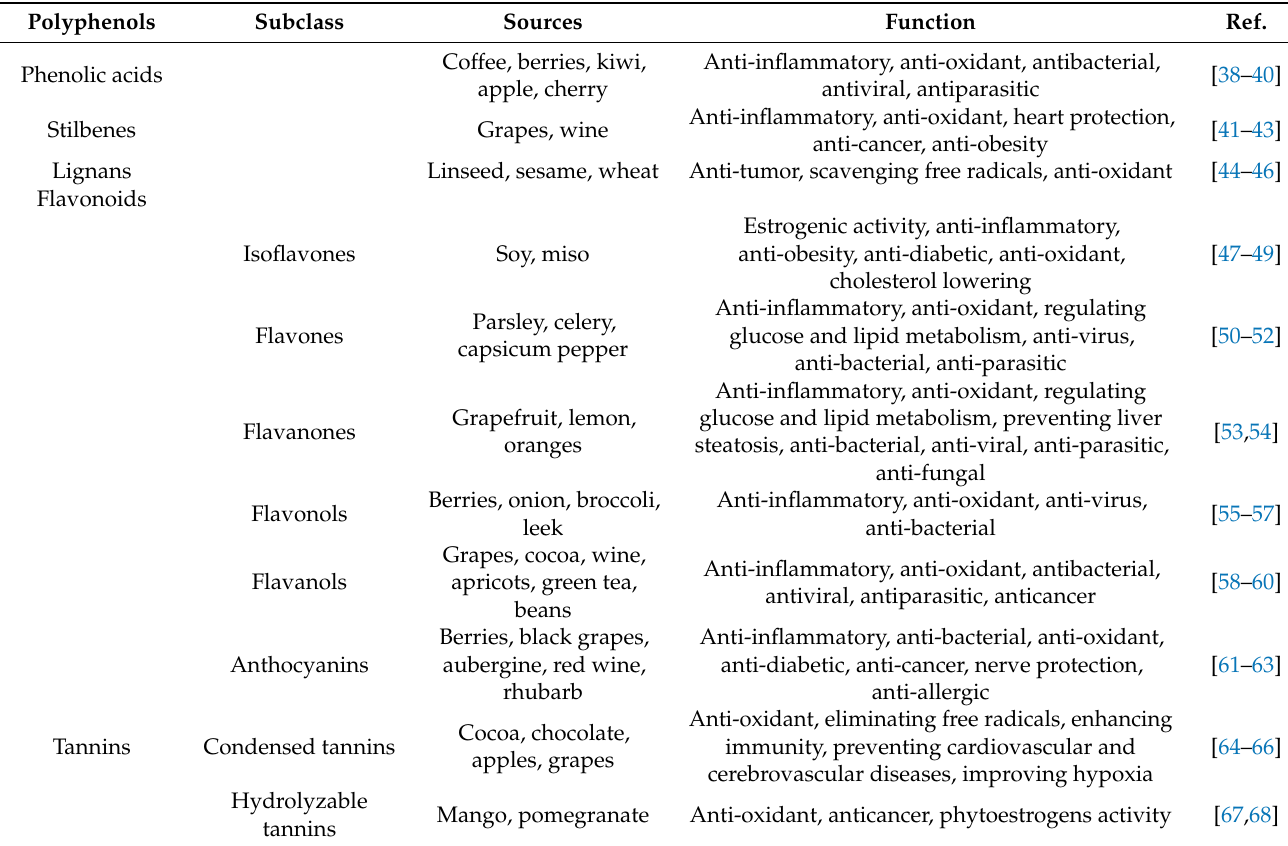
Table 1. Classification, sources, and functions of